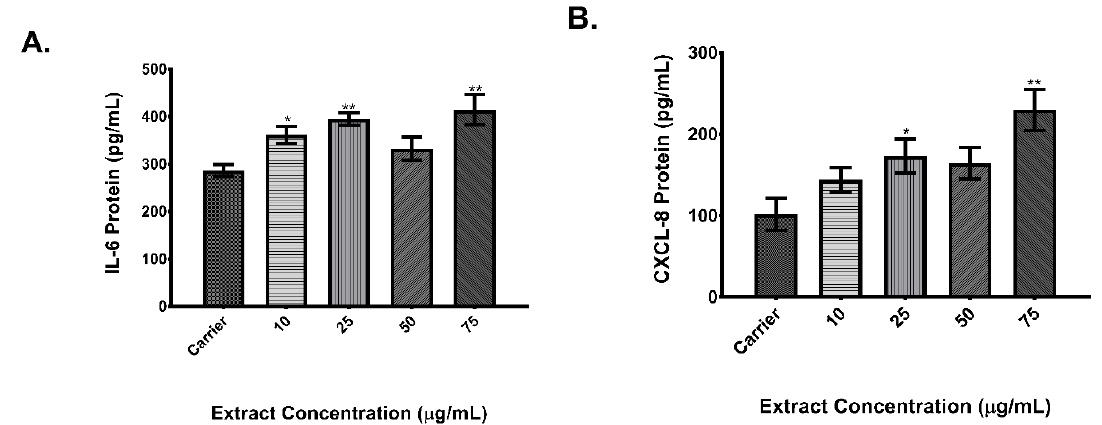
Atmosphere 2019 , 10 , x FOR PEER REVIEW 7 of 15 Figure 3. Dose response of rural organic extract. A total of 5.0 × 10 4 BEAS-2B cells were seeded on 96-well plates and exposed to increasing concentrations of the rural PM organic extract. IL-6 ( A ) and CXCL8 ( B ) protein levels were measured from cell supernatants after 24 h of exposure. Values are expressed as the mean ± SEM ( n = 3). * p ≤ 0.05, ** p ≤ 0.01 compared to carrier.